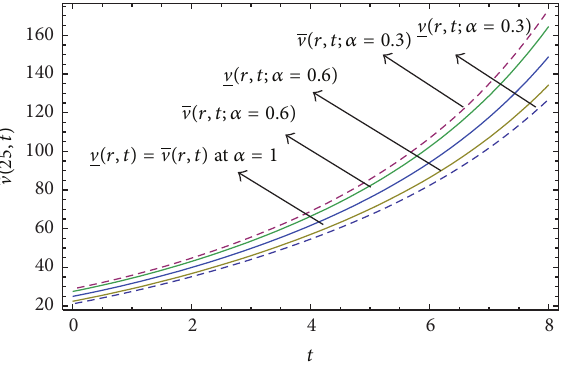
Figure 7: Interval solution of Case 2.